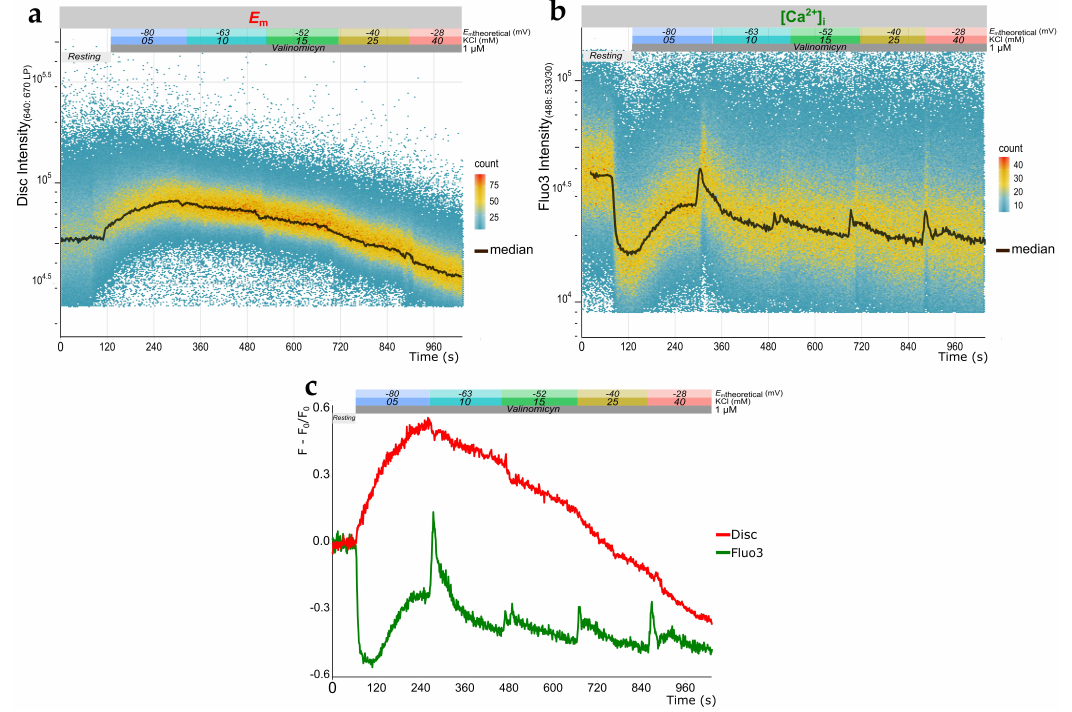
Figure 3. Multi-parametric measurement of membrane potential ( E m ) and intracellular calcium concentration ([Ca 2+ ] i ) changes in human sperm. Representative time-lapse flow cytometry (TLFC) 4-(6-acetoxymethoxy-2,7-dichloro-3-oxo-9-xanthenyl)-4 ′ -methyl-2,2 ′ (ethylenedioxy) dianiline-N,N,N ′ ,N ′ -tetra acetic acid tetrakis (acetoxymethyl) ester (Fluo3-AM, abbreviated to Fluo3) fluorescence density plots of a sperm sample from a known paternity donor, which was co-stained with DiSC 3 (5) (Disc) ( a ) and Fluo3 ( b ) to analyze E m and [Ca 2+ ] i changes, respectively, under capacitating conditions. Colored boxes above the plots indicate the nature and duration of the employed stimuli. ( c ) Normalized median fluorescence values ((F − F 0 )/F 0 ) of data shown in ( a ) and ( b ).